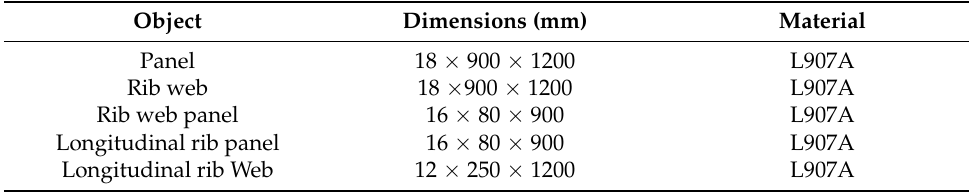
Table 1. Dimensions of the